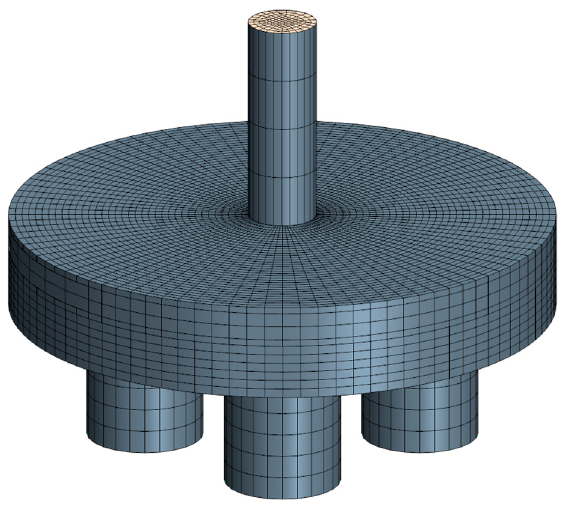
Figure 11. Result of the directed mesh via domain